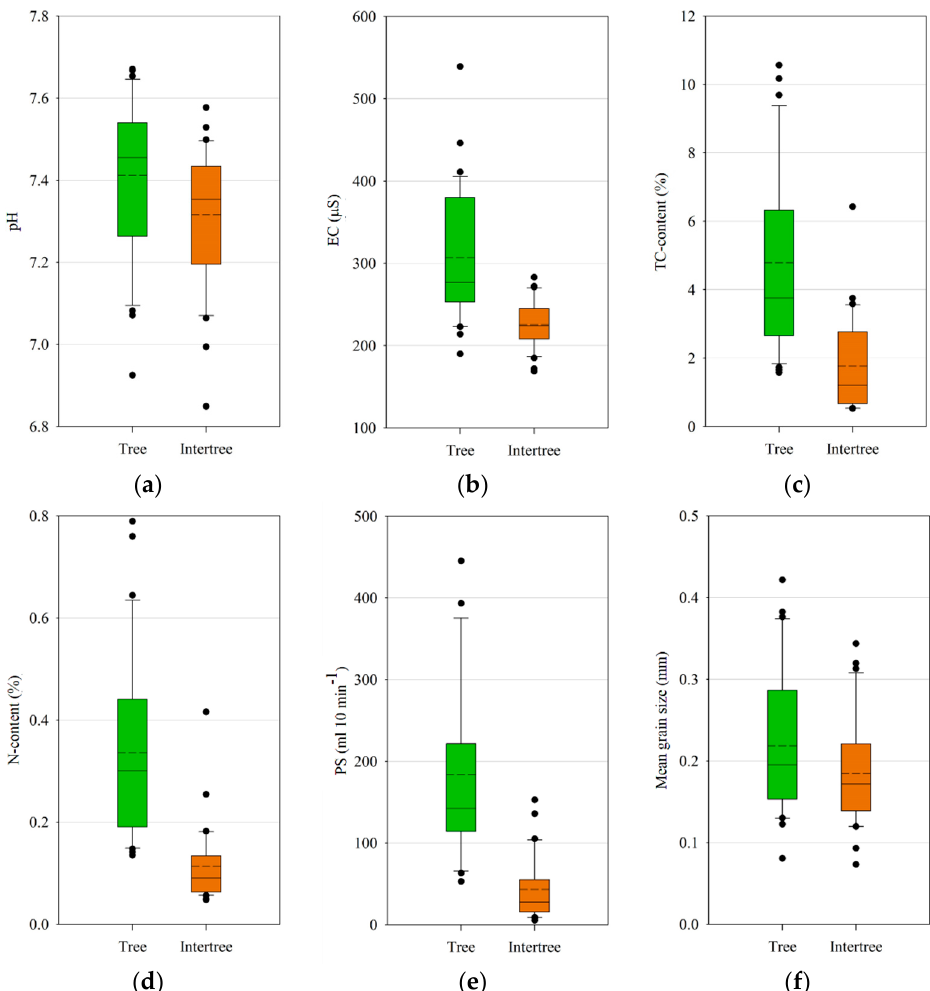
Figure 11. ( a ) pH ( p < 0.05), ( b ) electrical conductivity (EC) ( p < 0.05), ( c ) total carbon content (TC-content, p < 0.05), ( d ) nitrogen content (N-content, p < 0.05), ( e ) percolation stability (PS, p < 0.05), and ( f ) mean grain size (short dash: mean line, solid line: median, dots: outliers). Results for the tree-covered areas (left box) and intertree areas (right box).